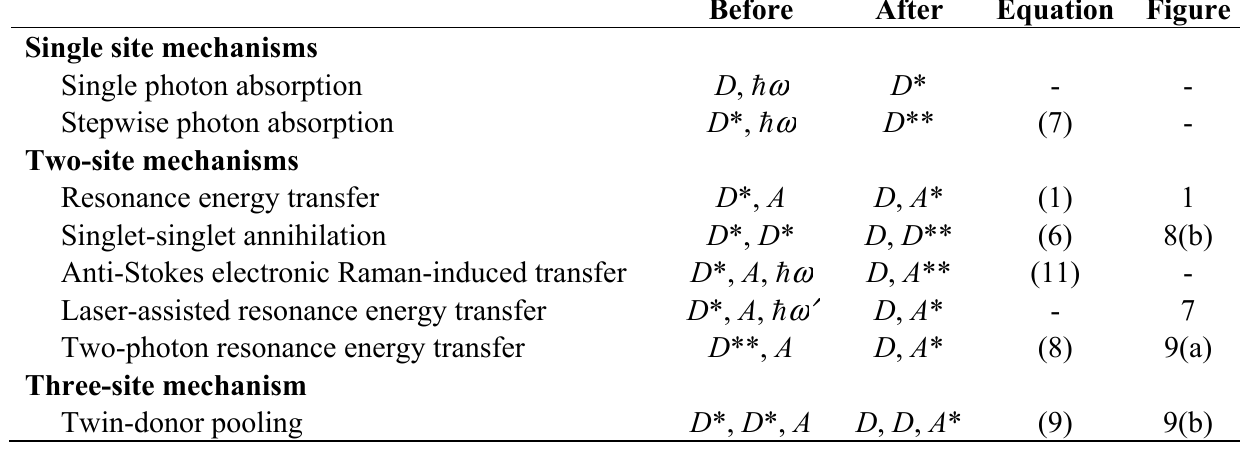
Table 1. Summary of key energetics: second and third columns represent the local energy landscape before and after each form of energy reconfiguration; h ω denotes a resonant photon, h ω′ one that is specifically